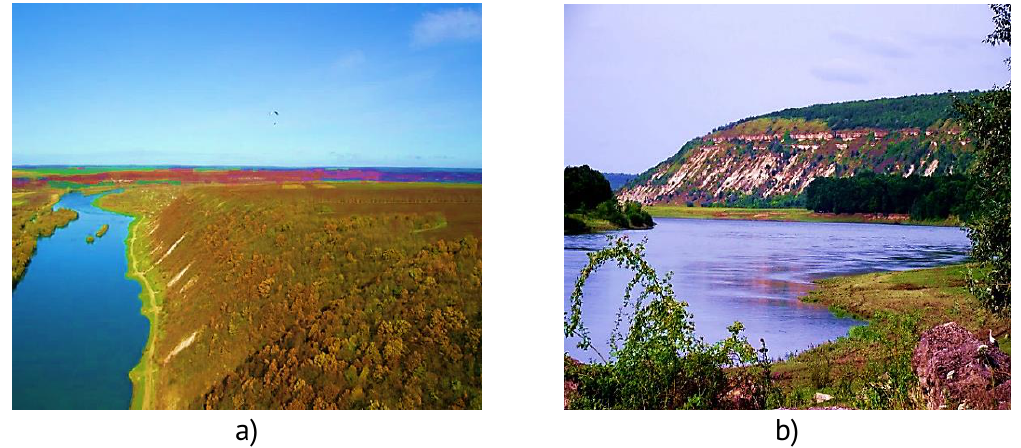
Figure 5. Two nice locations for a PSHPP on Nistru river: Soroca district, villages Inundeni (a) and Vertiujeni